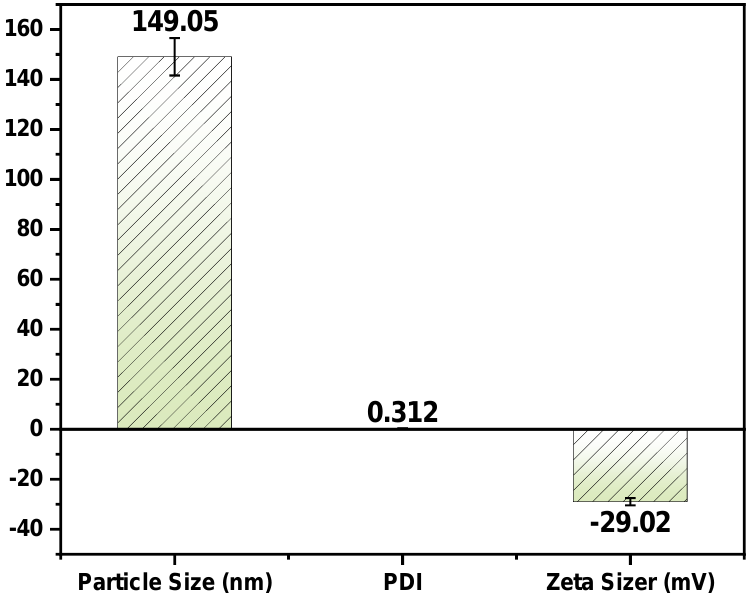
Figure 2. Measurement of particle size, polydispersity index, and zeta-potential AEOs emulgel-based transdermal formulation.